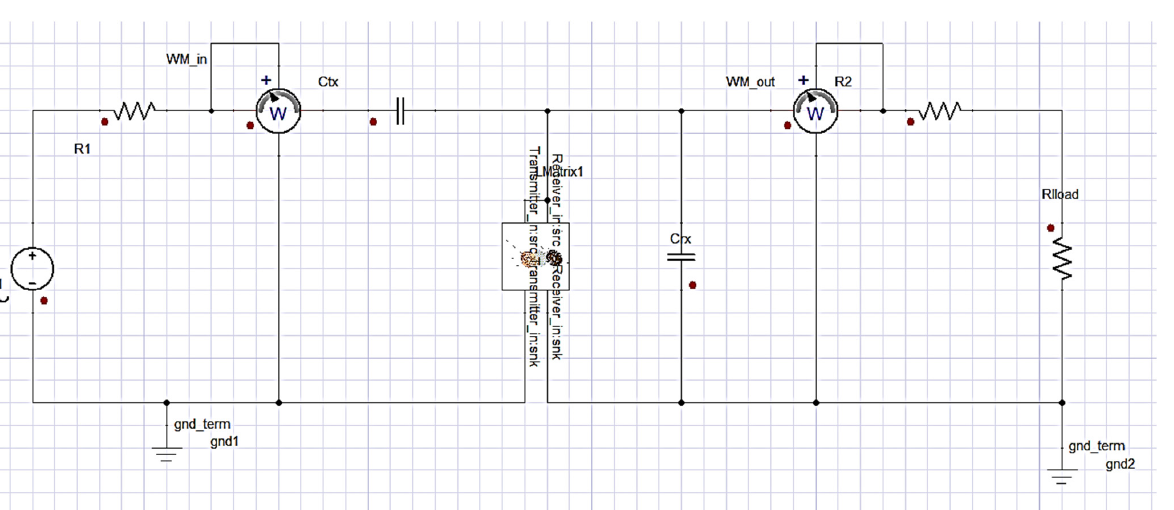
Table 2. Armatures for equivalent circuit.